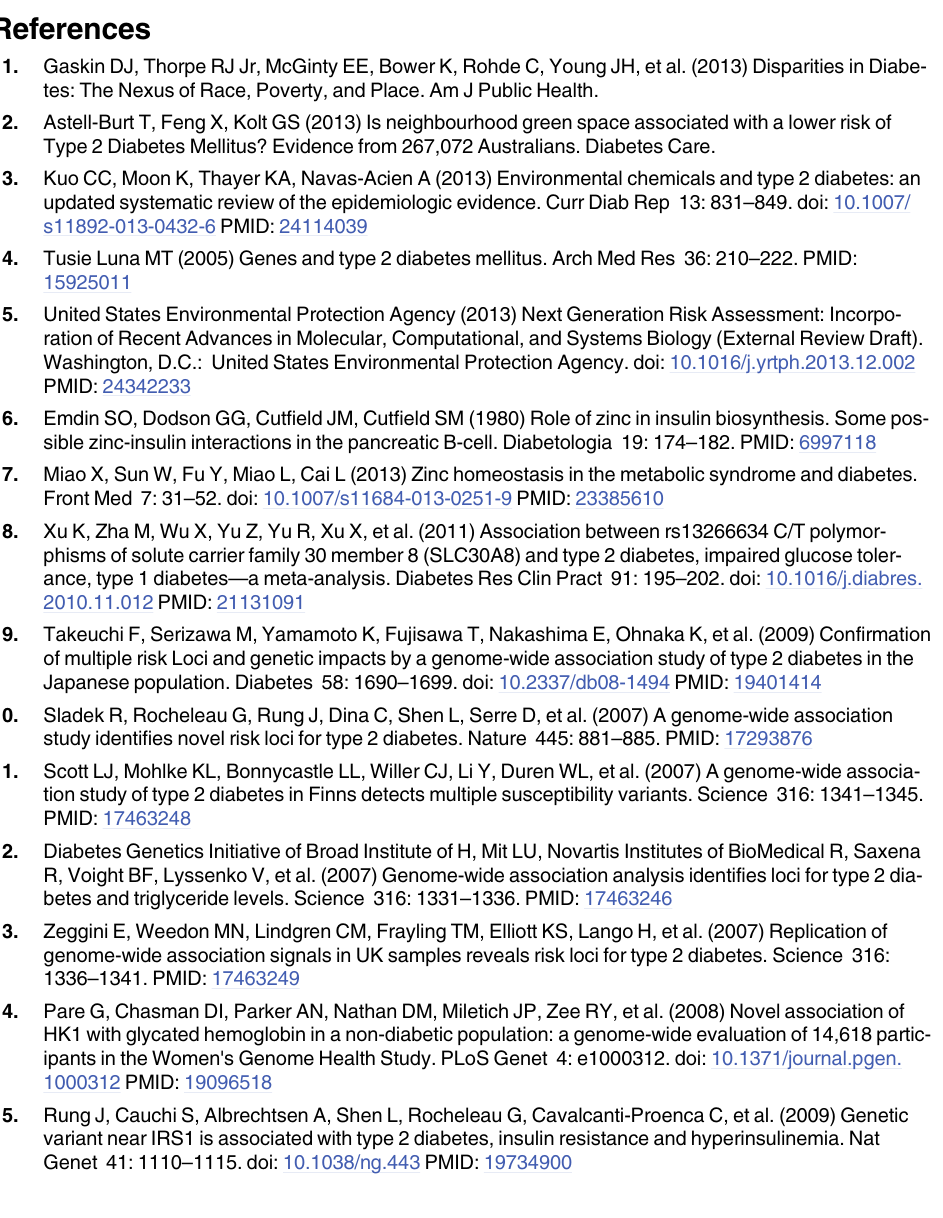
S3 Fig. Geographic distribution of PAR for Mexican-Americans across California. (PDF) S4 Fig. Geographic distribution of Total PAR across California. Total PAR is the subgroup population-weighted average PAR for the total population in each census tract (i.e., the sum of the Asian-American, Caucasians, and Mexican-American populations, see